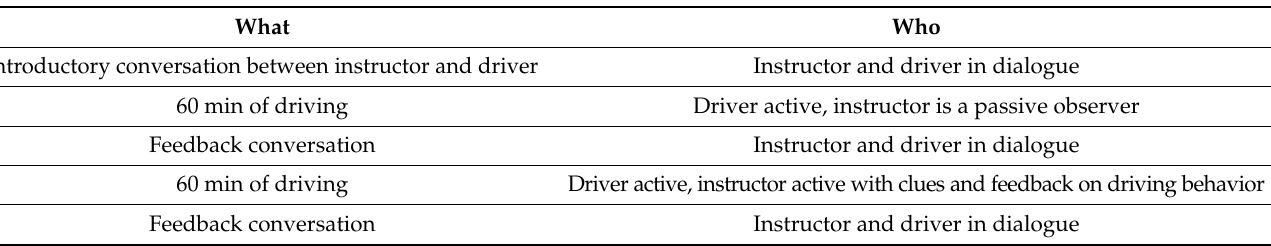
Table 6. Actual driver training module